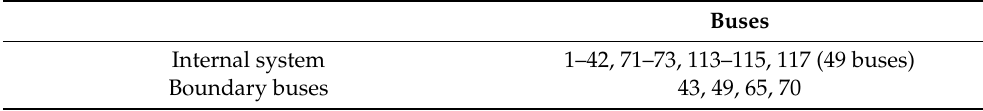
Table 2. Details of the system